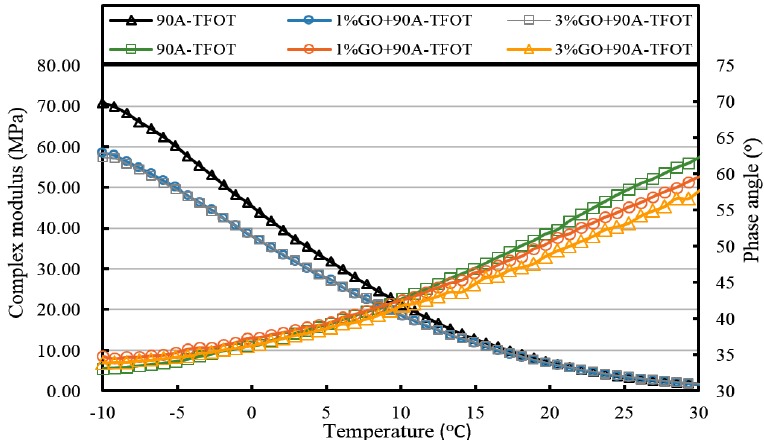
Figure 16. Complex modulus and phase angle of GO-modified 90A and its matrix at low temperature after TFOT aging.